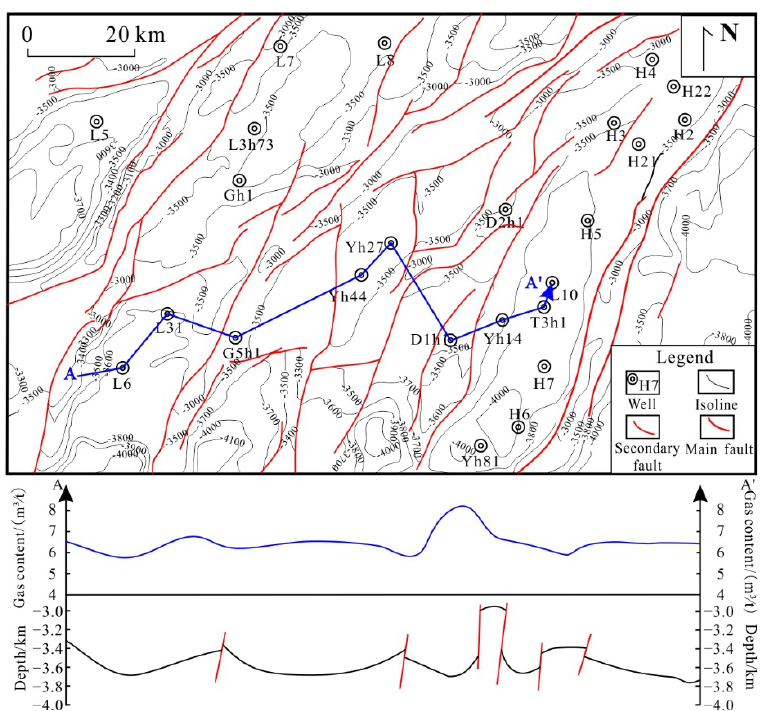
Figure 8. Comprehensive diagram of burial depth and gas content of the Longmaxi Formation drill- ing